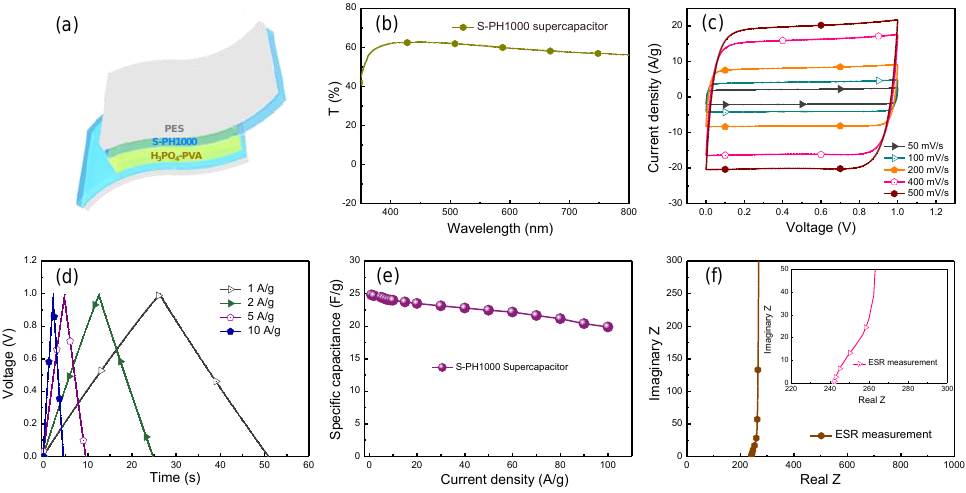
Figure 4. ( a ) Device structure of semi-transparent flexible supercapacitors: PES / S-PH1000 / H 3 PO 4 -PVA / S-PH1000 / PES. ( b ) The transmittance of the semi-transparent supercapacitor device. ( c ) CV curves of the S-PH1000 semi-transparent supercapacitors recorded at di ff erent scan rate of 50, 100, 200, 400 and 500 mV / s. ( d ) Galvanostatic charging / discharging (GCD) profiles of the semi-transparent supercapacitors recorded at di ff erent current densities of 1, 2, 5, 10 A / g. ( e ) A graphical representation of the variation of specific capacitance with respect to the current density. ( f ) Nyquist plot of the S-PH1000 semi-transparent flexible supercapacitor together with an enlarged photograph in the inset.